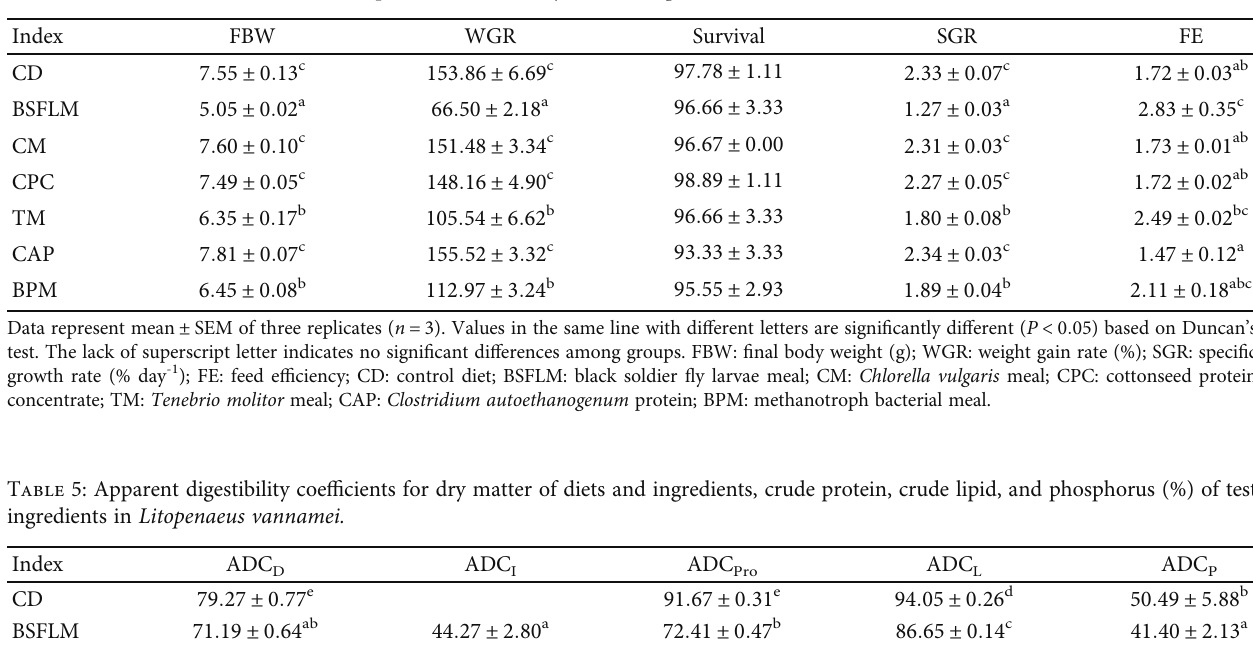
Table 4: Growth performance of the juvenile Litopenaeus vannamei fed with di ff erent diets.